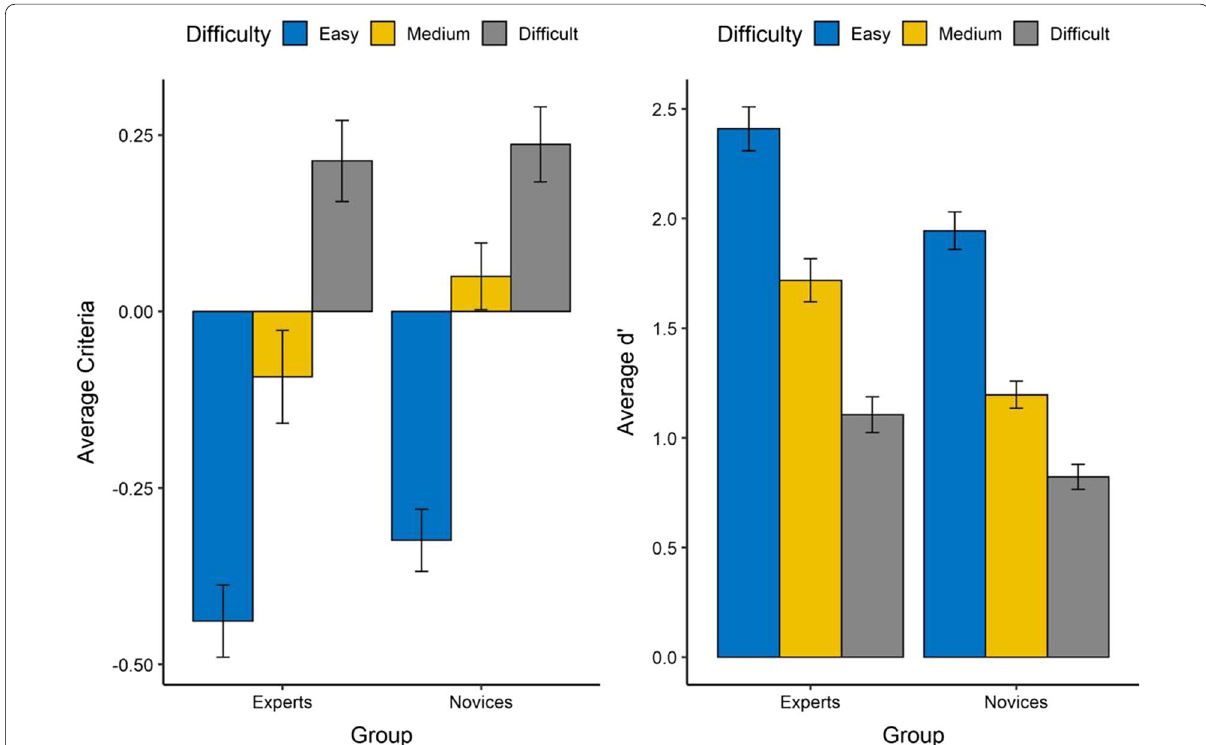
Fig. 4 The average criteria and d ’ for the group of experts and novices as a function of the levels of difficulty in the high‑prevalence condition. The error bar represents one standard ±